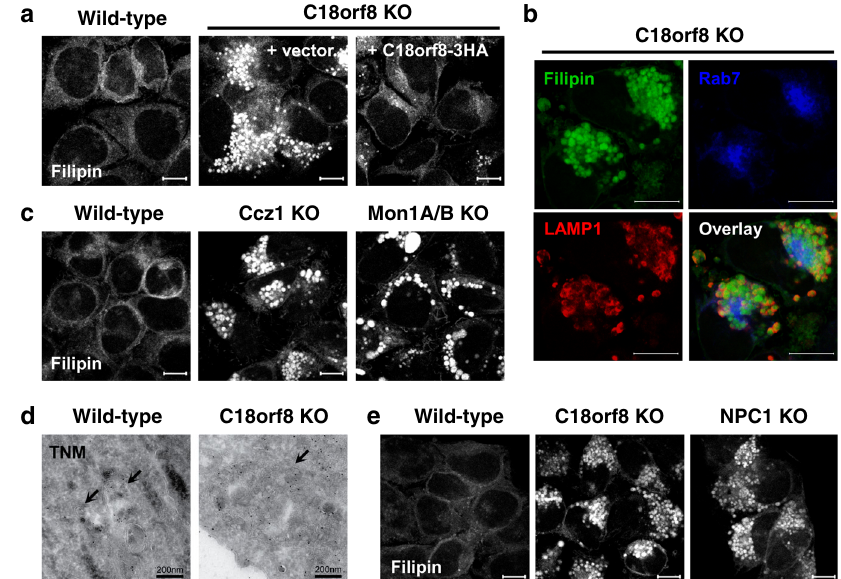
Fig. 7 C18orf8-, Ccz1- and Mon1A/B- (MCC)- de fi cient cells accumulate free cholesterol in a swollen lysosomal compartment. a Filipin staining of wild- type, C18orf8 -de fi cient and complemented C18orf8 -de fi cient cells; or c wild-type, Ccz1- and Mon1A/B -de fi cient cells. b Filipin (green) co-staining with the LE/Ly markers Rab7 (blue) and LAMP1 (red) in C18orf8 -de fi cient cells. d Theonellamides (TNM) immuno-gold labelling of wild-type and C18orf8 -de fi cient cells, visualised by EM. Multivesicular bodies (MVBs) are indicated by arrows. Note MVBs are markedly enlarged in C18orf8 -de fi cient cells. e Filipin staining of wild-type, C18orf8 - and NPC1 -de fi cient cells. All confocal microscopy images are representative of fi ve fi elds per condition and two independent experiments. Scale bars for confocal microscopy = 10 µ m, scale bars for EM = 200